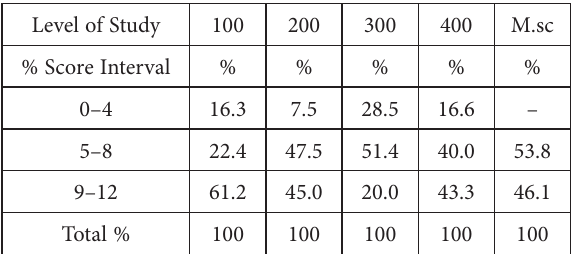
Table 7. Percentage distribution of score interval on